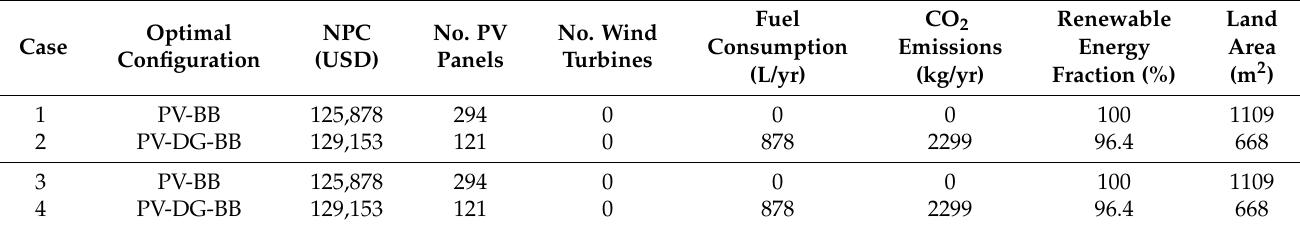
Table 21. Comparison of optimal configurations for the Wafra cell-site.